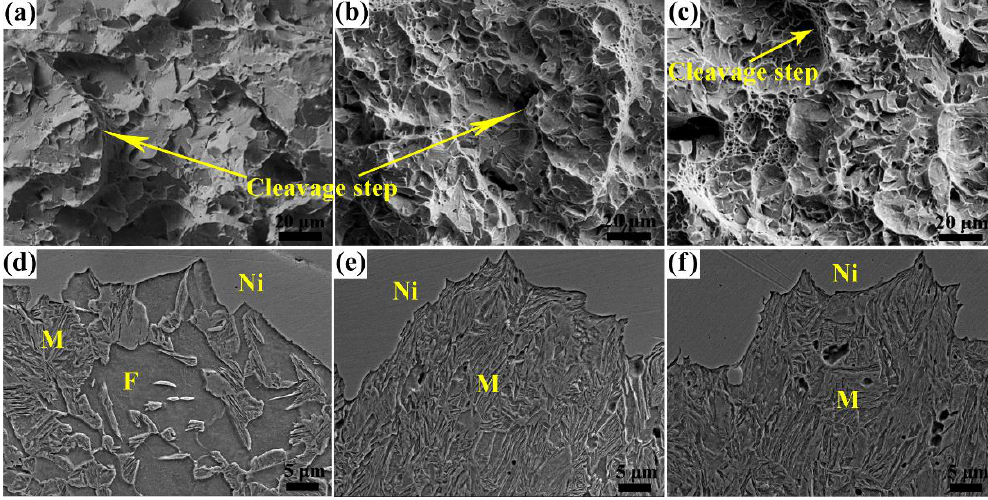
Figure 10. SEM images of the −40 °C impact fracture morphology and microstructure underneath the fracture surface of the specimens tempered at 180 °C with ferrite content of ( a , d ) 37 vol%, ( b , e ) 3 vol%, and ( c , f ) none, respectively. (Ni = coated nickel layer).